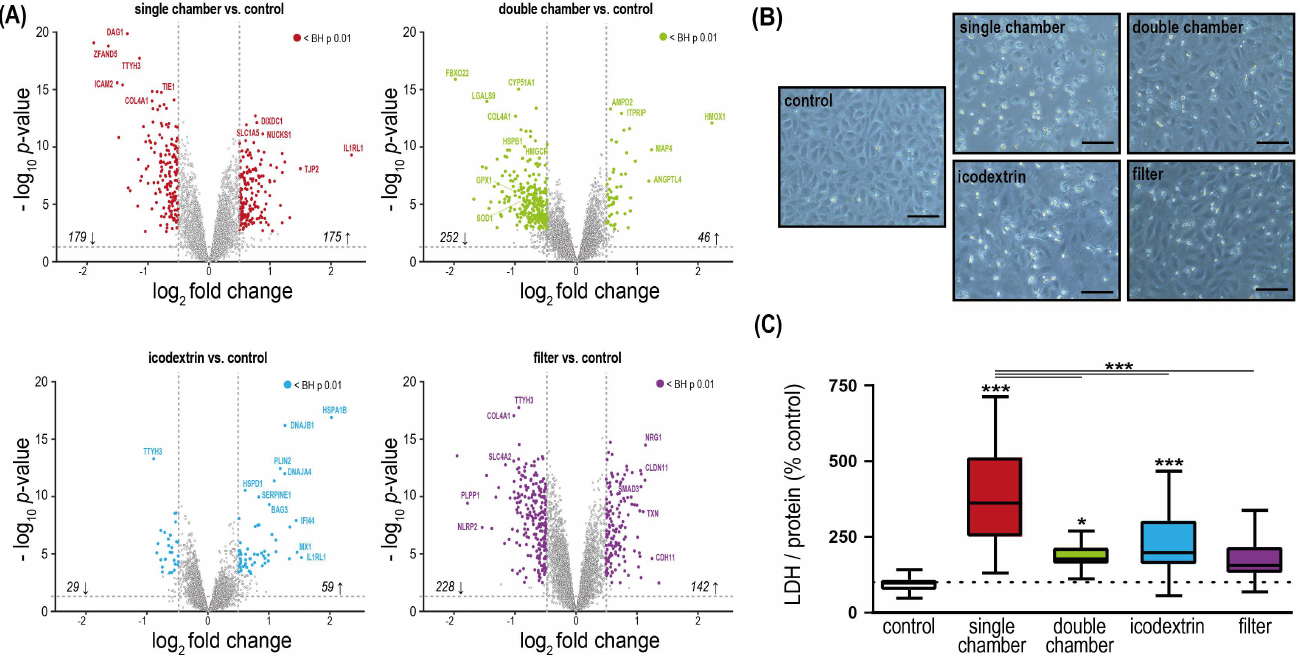
Figure 1. Change of endothelial cell proteome and morphology induced by PD fluid exposure. Primary human umbilical vein endothelial cells (HUVEC) from three different donors were exposed to standard clinically used PD fluids (single-chamber fluid: acidic pH, high concentrations of glucose degradation products (GDPs), an icodextrin-based PD fluid, and a filter-sterilized lab-made PD fluid based on the composition of the single-chamber fluid (filter). ( A ) Volcano plots for regulated proteins in HUVEC exposed to different PD fluids vs. control cell culture medium. p < 0.01 for all points